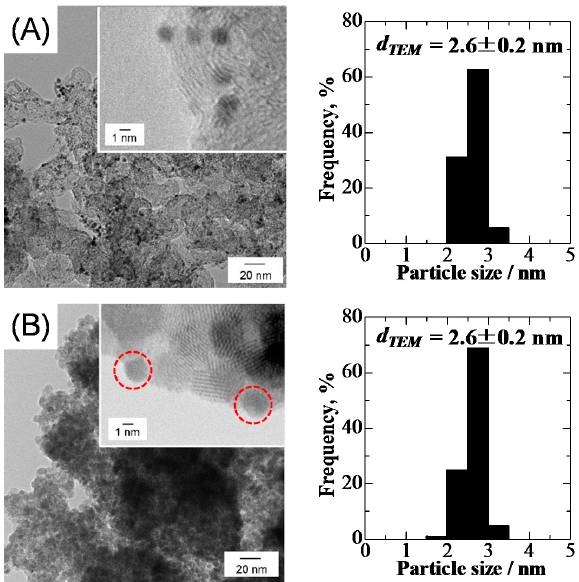
Figure 2. TEM (transmission electron microscopy) images and particle size distribution histograms of pristine ( A ) Pt 2 Ru 3 /CB and ( B ) Pt 2 Ru 3 /Sb ‐ SnO 2 . Table 1. Typical properties of Pt 2 Ru 3 /CB and Pt 2 Ru 3 /Sb ‐ SnO 2 catalysts a .